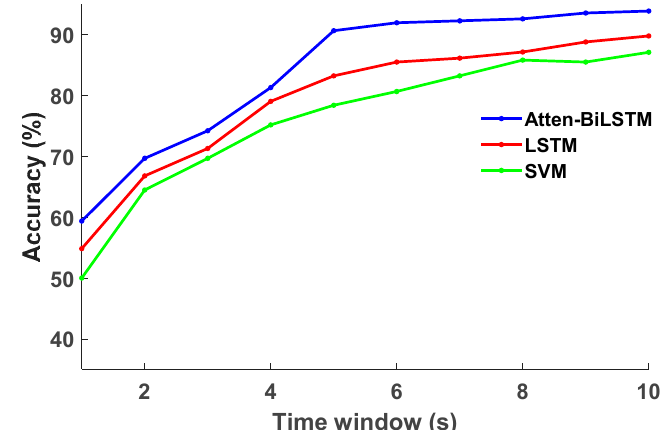
Figure 10. The recognition accuracy under different time window lengths.